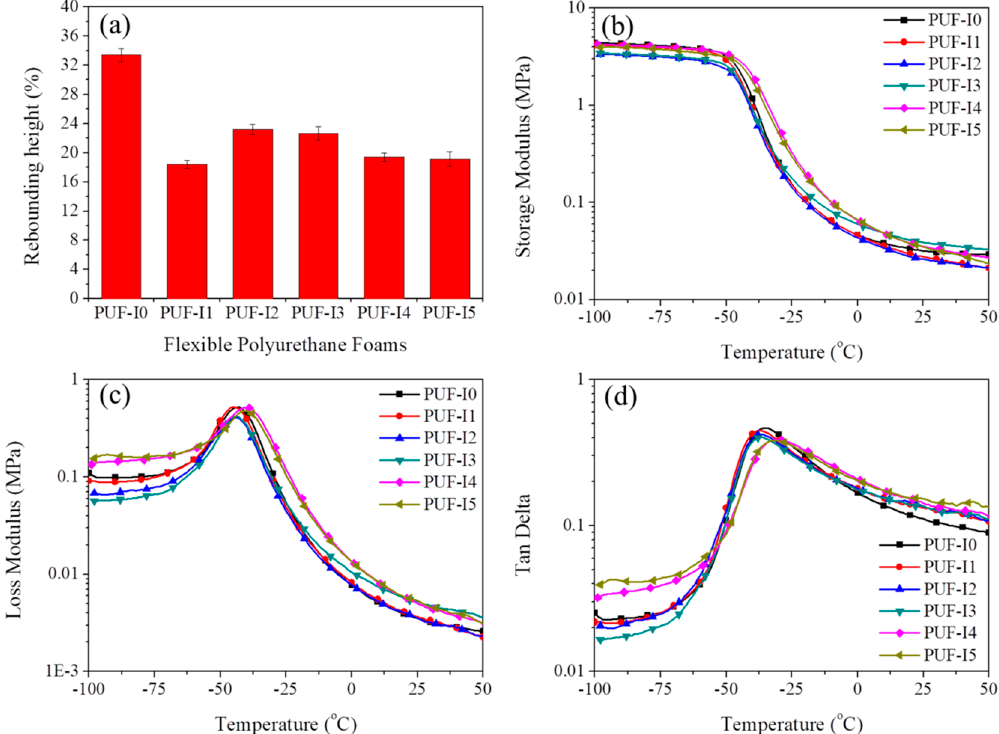
Figure 4. CFD of FPUFs with various ISB content.